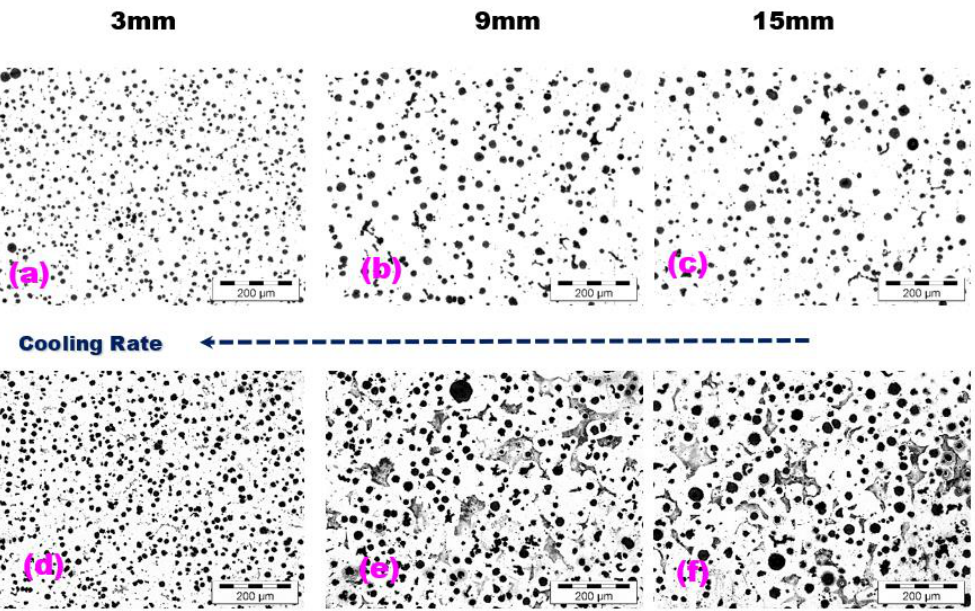
Figure 5. Influence of the wedge casting wall thickness on the structure of the 4.5%Si Un-inoculated ductile cast iron ( a , d ) 3 mm; ( b , e ) 9 mm; ( c , f ) 15 mm; ( a – c ) un-etching; ( d – f ) Nital etching.